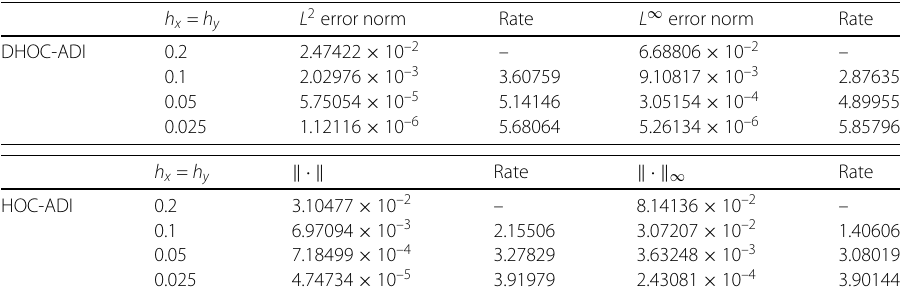
Table 4 The error norms of numerical solutions and the rate of convergence in space where τ = 2.5 × 10 –6